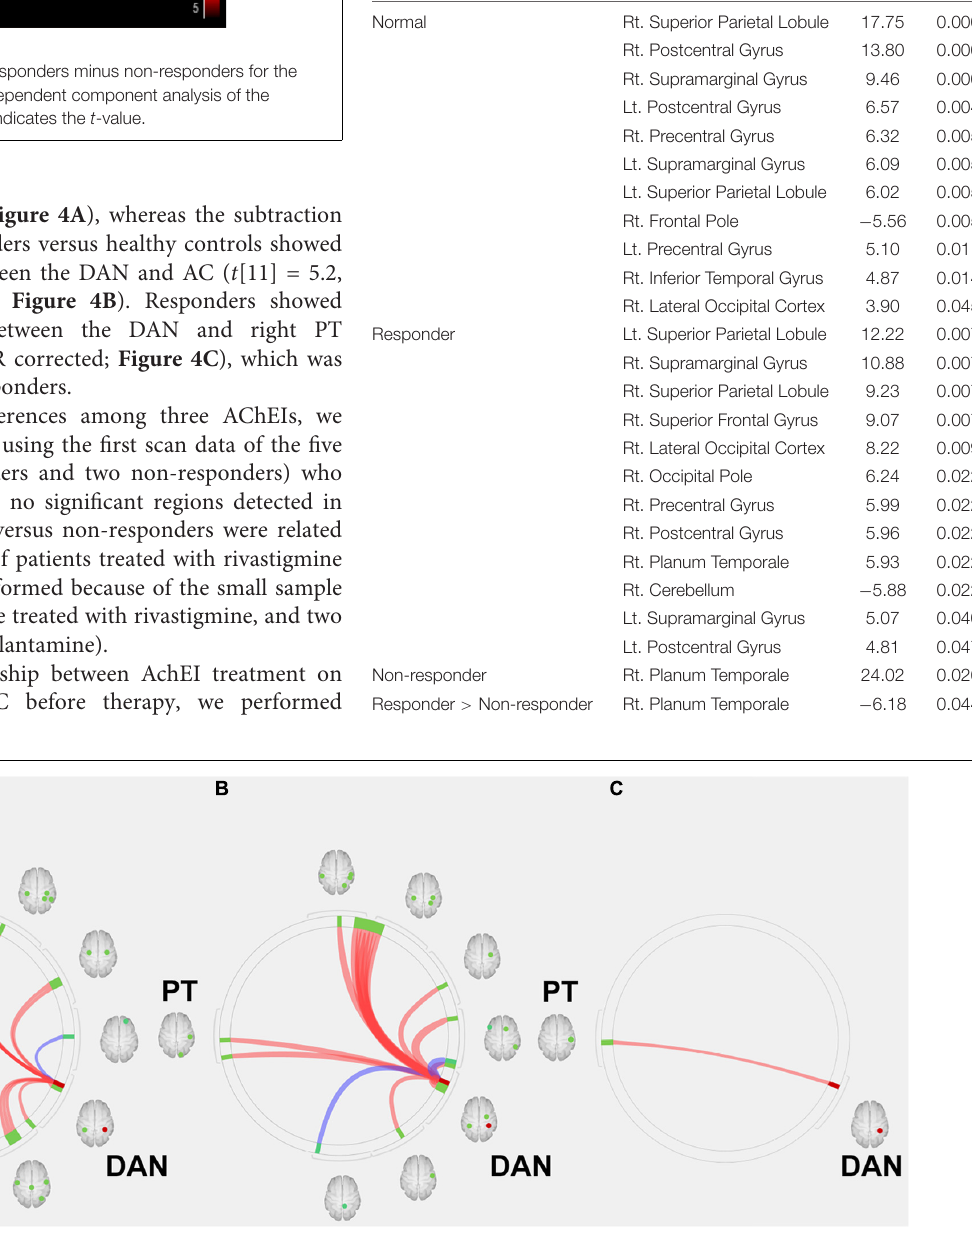
Frontiers in Aging Neuroscience |